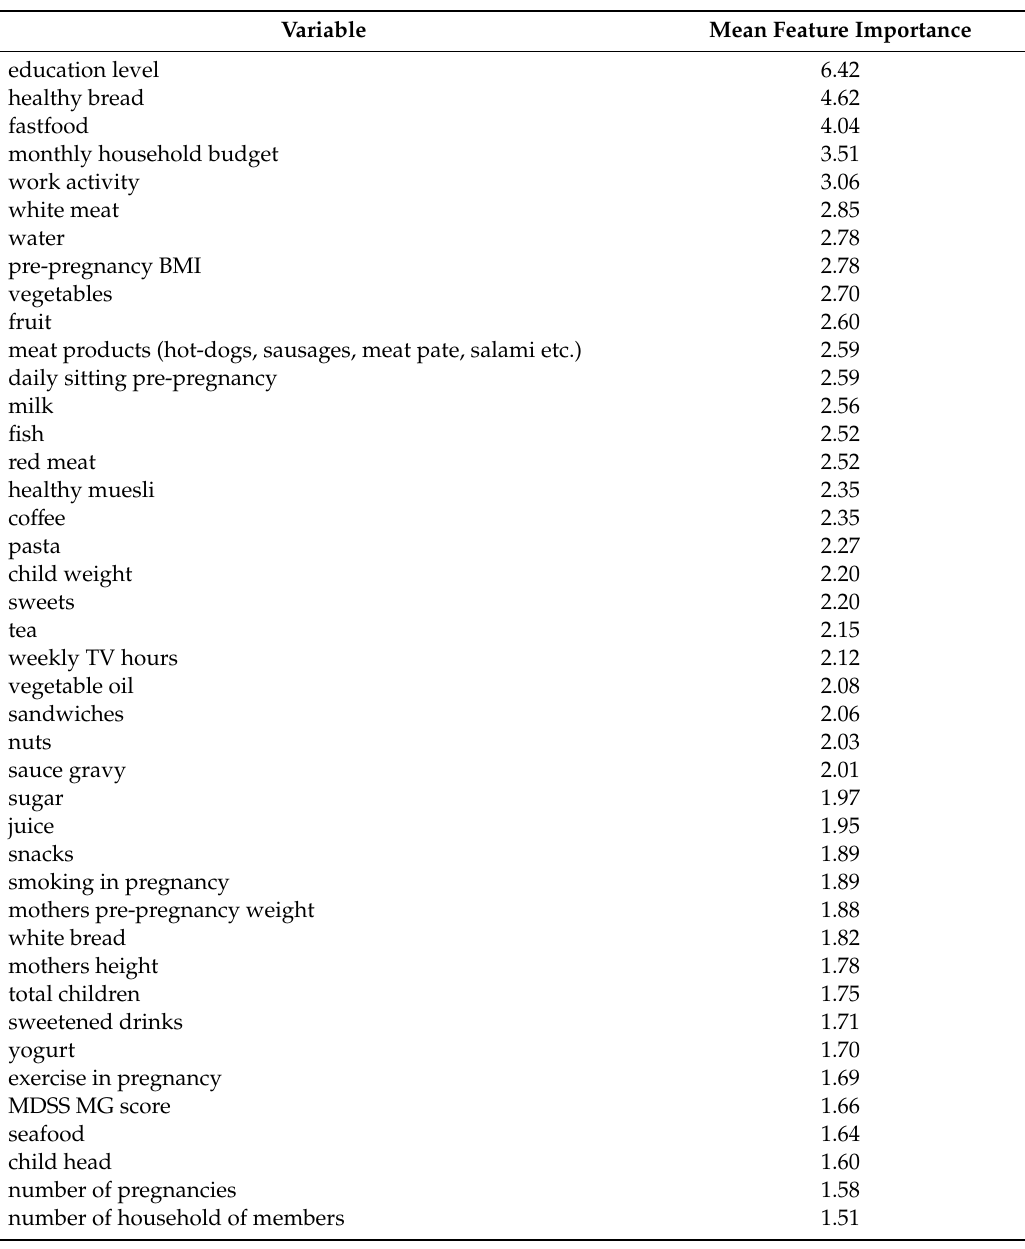
Table A4. Selected variables employed in